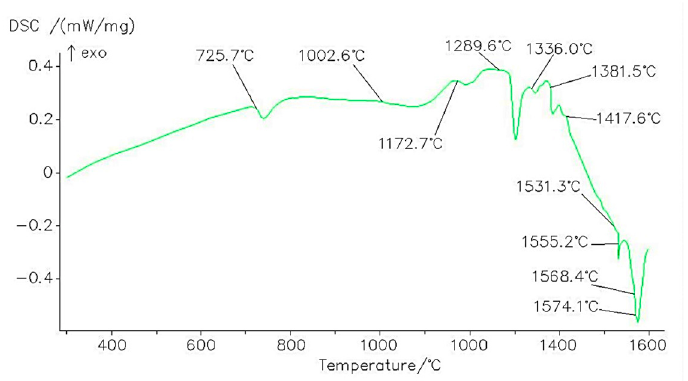
Figure 8. Heating curve of the carbide coating.